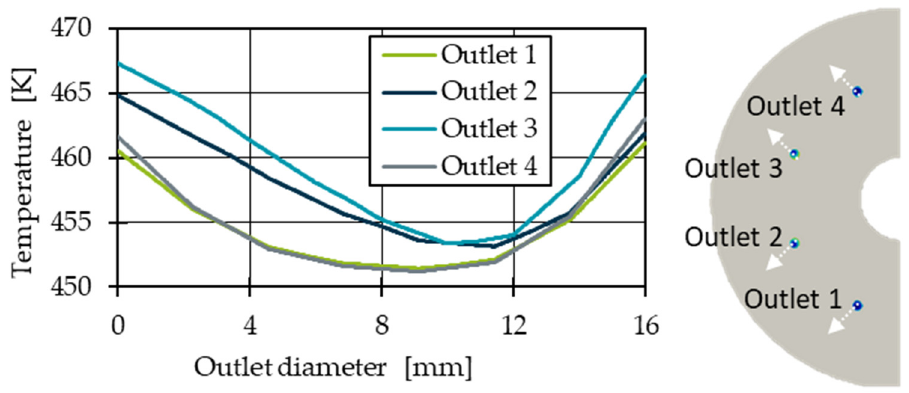
Figure 8. Temperature distribution in the cross section of each individual outlet.